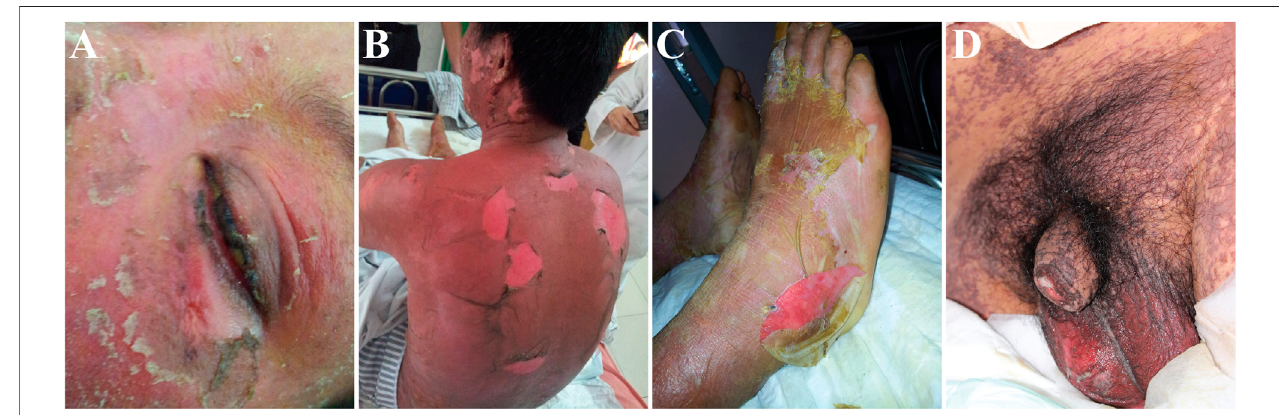
FIGURE 1 | Representative images showing dermatological manifestations of patients with Stevens – Johnson syndrome (SJS) and toxic epidermal necrolysis (TEN). The patients participated in a clinical study approved by the Ethics Committee of the Institute of Clinical Pharmacology, Central South University (CTXY- 110011 – 2). The informed consent forms were signed for the publication of the photos. (A) Skin erosion on the face and mucous damage in the eye; (B) extensive skin sloughing in the trunk; (C) skin peel in the feet; (D) painful mucous membrane damage in the